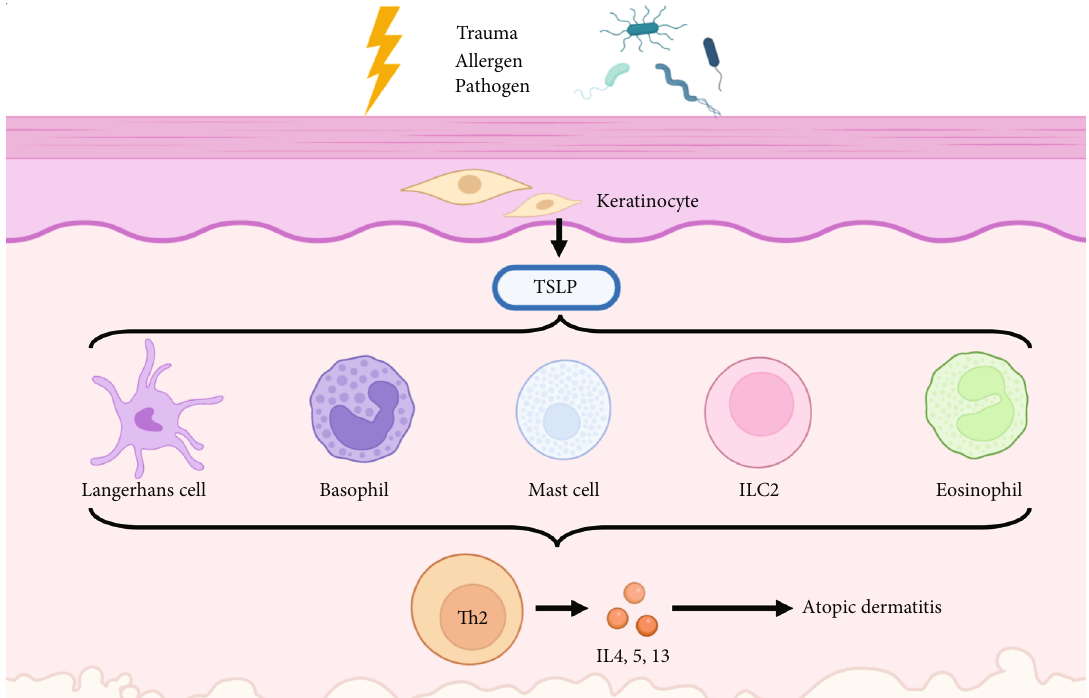
Figure 1: The schematic of TSLP in AD pathogenesis. Firstly, the release of TSLP from keratinocytes is elevated after exposed to allergens, pathogens, and trauma. TSLP directly acts on multiple immune cells (including LCs, basophils, mast cells, eosinophils, and ILC2s) to initiate and maintain allergic in fl ammation. Then, these immune cells synergistically drive the Th2-predominating immune responses to promote atopic